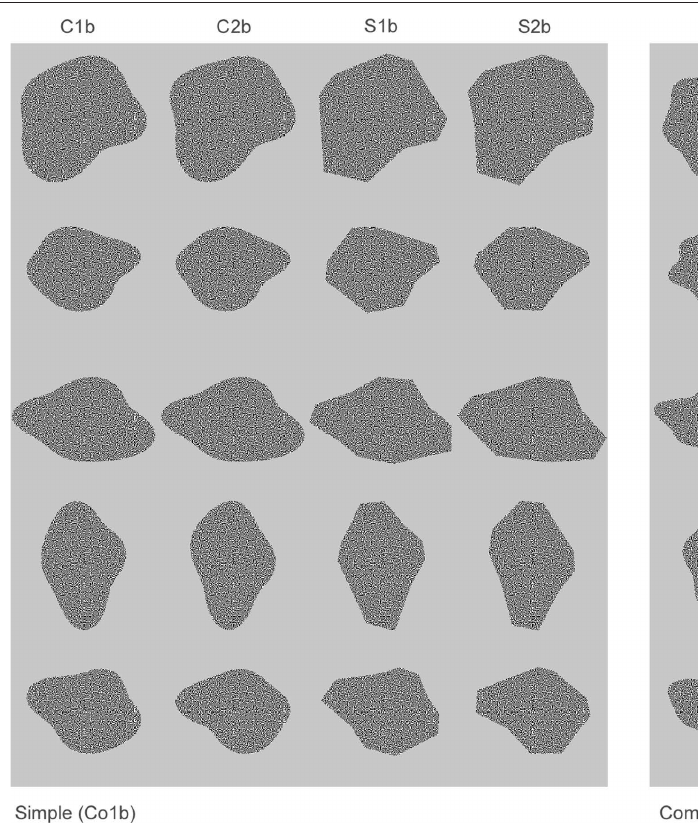
C1b and C2b are curved and differ in the phase of their FBDs. The shapes in columns S1b and S2b are created by replacing the curves of the shapes in respectively C1b and C2b with straight lines. We used small and large versions of each of the stimuli, and during the recordings the set was divided in two subsets: 1 containing the first three rows of the global set and 1 containing the two